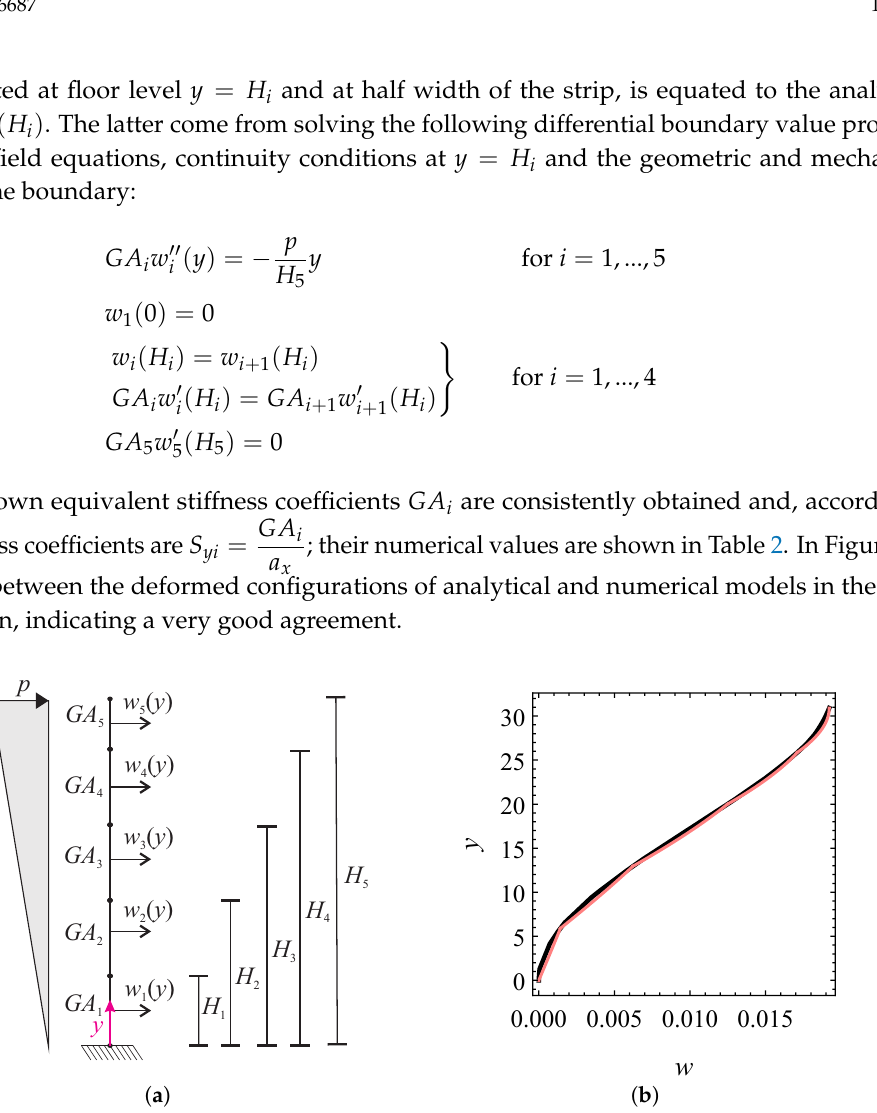
Figure 11. ( a ) scheme of the equivalent shear beam system with axis y ; ( b ) comparison between analytical (pink line) and numerical (black line) deformations in the y − z plane; quantities in meters.